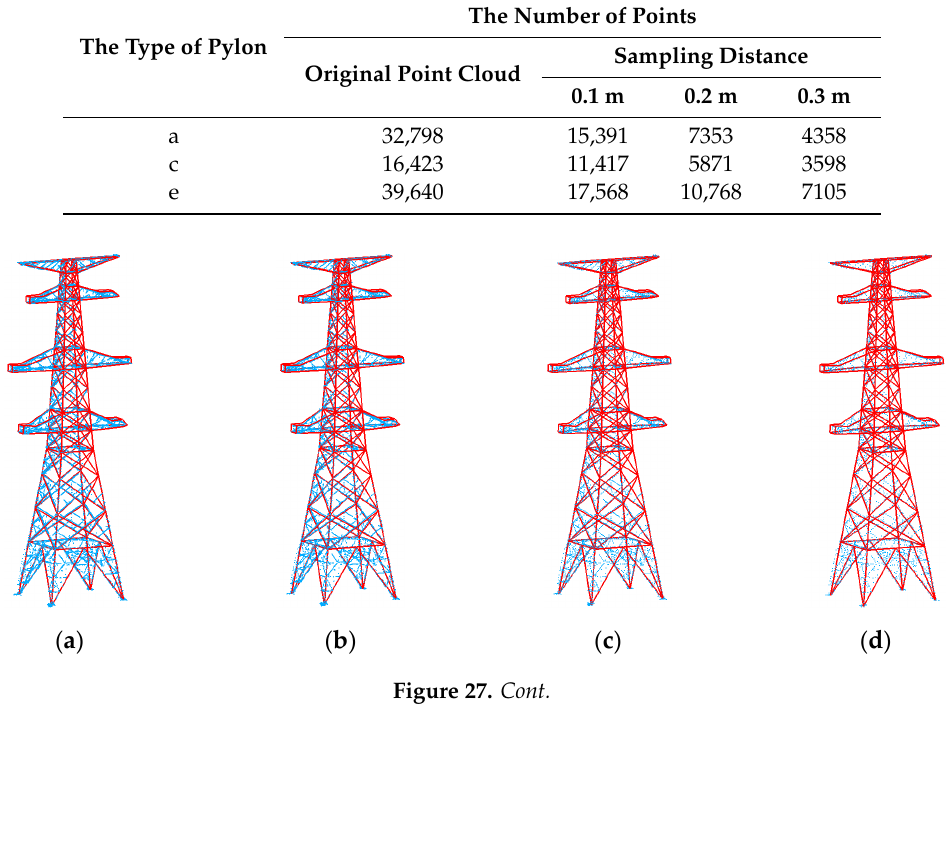
Table 12. The number of pylon points sampled uniformly.